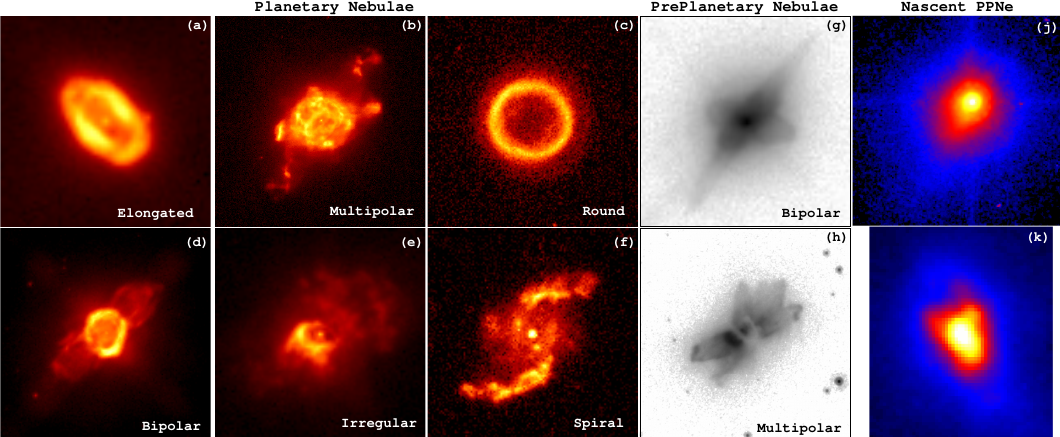
Figure 1. YPNe, PPNe, and nascent PPNe images from HST—( a – f ) H α (or [NII]) images of PNe belonging to 6 primary classes in the Sahai, Morris, and Villar (2011) [5] classification system, which consists of 7 primary classes based on the overall nebular shape, and several categories of secondary characteristics related to specific properties of the lobes, waist, and haloes, and the presence of point-symmetry; ( g , h ) 0.6 µ m images of PPNe belonging to 2 primary classes; and ( j , k